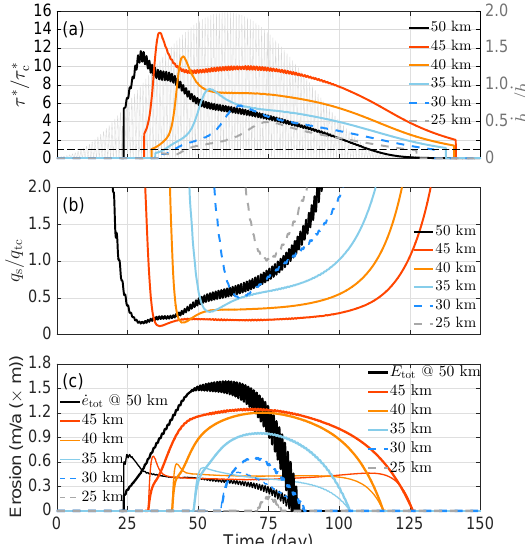
Figure 5. Time series at six different distances from the di- vide (km 50, 45, 40, 35, 30 and 25) for simulation T_REF (Ta- ble 4). (a) Transport stage ( τ ∗ /τ ∗ c ) and normalized meltwater input ( ˙ b ca / ˙ b ssmax ) at the terminus (light grey). The dashed line repre- sents the threshold for sediment motion: τ ∗ /τ ∗ c = 1. (b) Relative sediment supply q s /q tc . (c) Erosion per unit width ˙ e tot (ma − 1 , thin lines) and total erosion E tot (m 2 a − 1 , thick lines) computed with the TLEM.